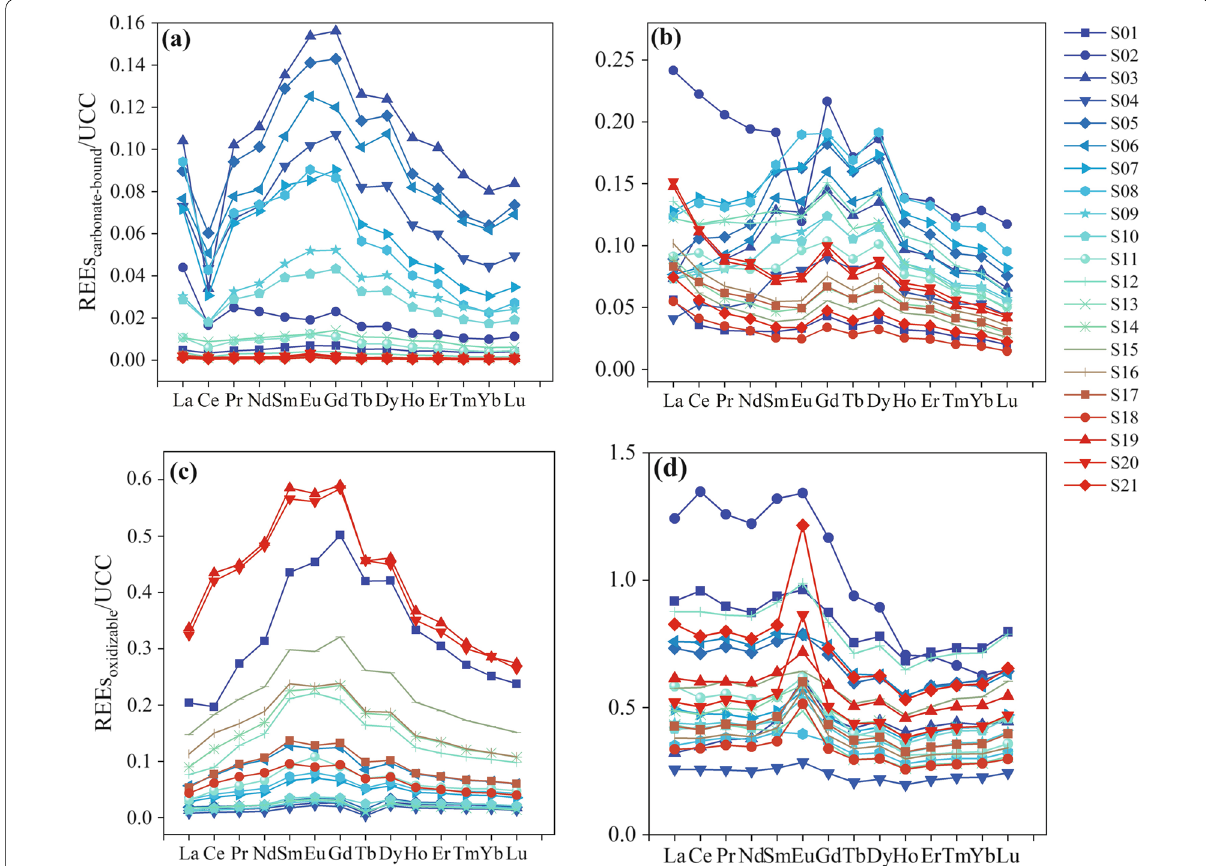
Fig. 3 Upper continental crust (UCC) normalized patterns of a carbonate‑bound REE, b reducible REE, c oxidizable REE, and d residue REE in topsoils (0–10 cm) along the northern China